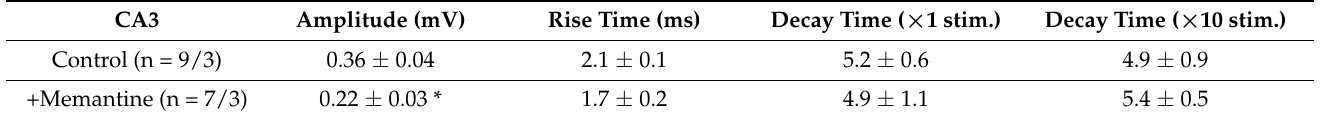
Table 2. Amplitudes and kinetics of fEPSPs of the ventral hippocampal CA3 area. Are shown the decay time after one (×1 stim.) or ten (×10 stim.) stimuli. Asterisks indicate statistically significant differences (* p < 0.05; n are numbers of tested areas and animals (areas/animals)). Decay Time CA3 Amplitude (mV) Rise Time (ms) (×1 stim.)